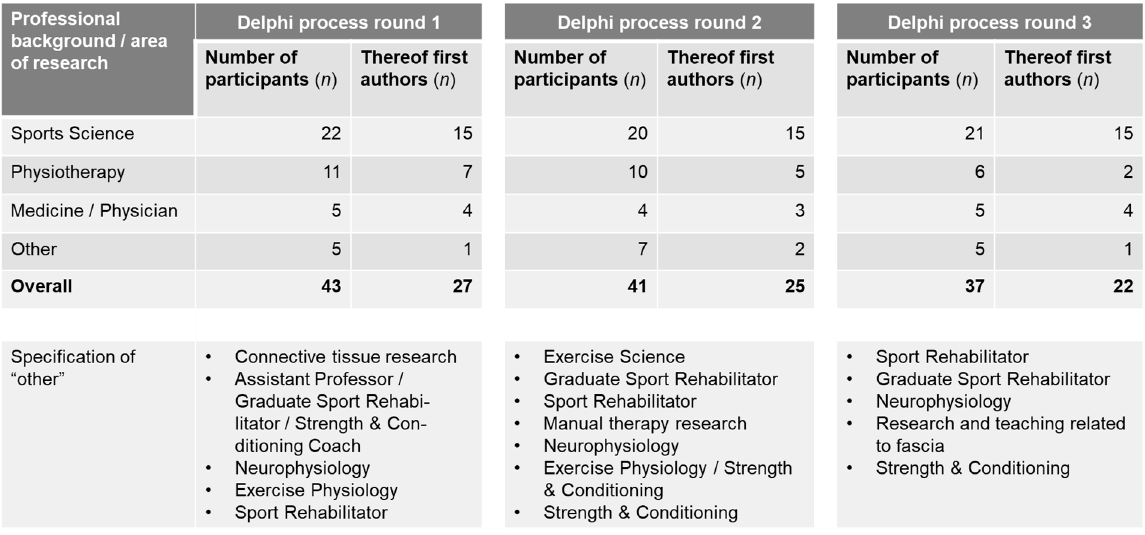
Figure 5. Overview of participant characteristics.